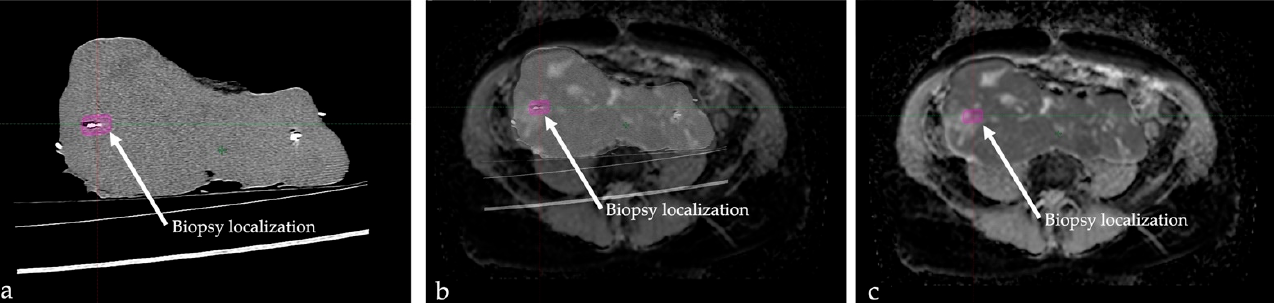
Figure 2. Fusion imaging of a leiomyosarcoma of the vena cava. ( a ) Postoperative CT of the speci- men. One inserted biopsy marker is highlighted in pink (arrow). ( b ) Fusion sequence of